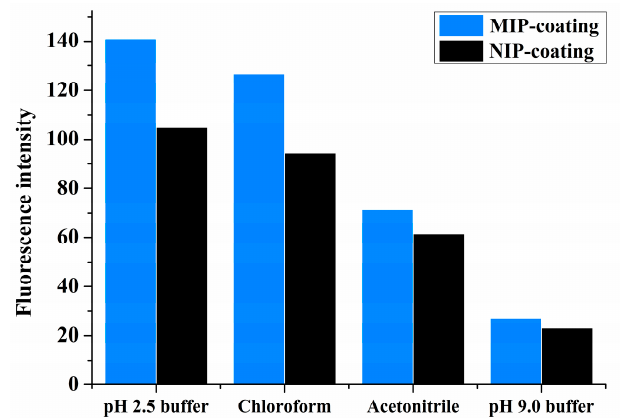
Figure 3. Fluorescence intensities of MIP- and NIP-coated quartz chips in different solutions (5 mg·L − 1 IBA solution, λ ex/em = 294/370 nm).